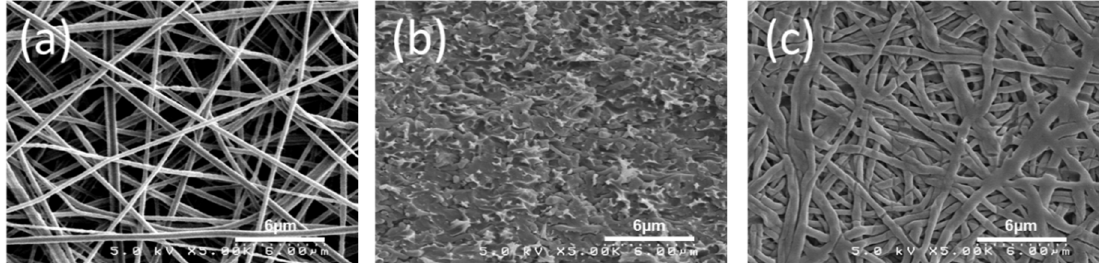
Figure 3. SEM images of ( a ) an electrospun Nafion/PPSU dual nanofiber mat; ( b ) freeze-fractured cross section of 57 vol% N(fibers)/PPSU; and ( c ) surface of the Nafion fiber structure after extraction of all PPSU with liquid chloroform. Magnification 5,000X.